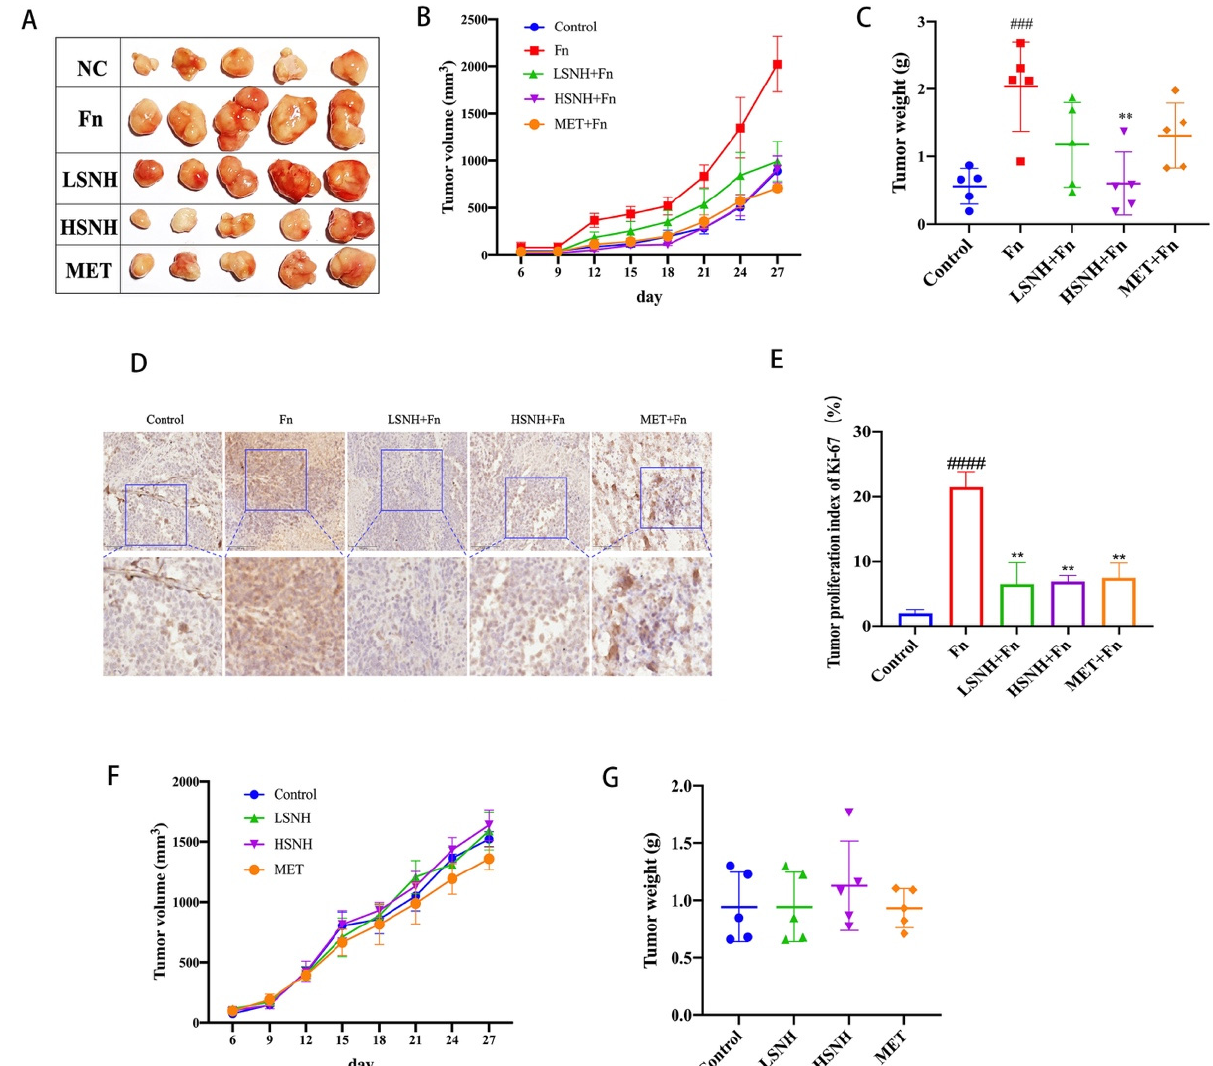
Figure 5. Effect of SNH on the growth of the CRC cells HCT116-xenograft tumors with intratumor colonization of Fn . ( A – C ), Gross image of tumors ( A ), tumor volume ( B ), and tumor weight ( C ) of tumors from the HCT116-engrafted mice inoculated with Fn in the presence of low-dose SNH (LSNH), high-dose SNH (HSNH), or the positive control drug MET. Time course effects of tumor volume were recorded in B. Endpoint of tumor appearance and tumor mass were shown in ( A , C ), respectively. ( D ) Immunohistochemistry of Ki-67 + cancer cells in the HCT116-tumor xenografts under different treatments as indicated. ( E ) Quantitation of Ki-67 + cancer cells in ( D ). ( F , G ) Tumor volume ( F ) and tumor weight ( G ) of HCT116 cells-xenografts in mice treated with LSNH and HSNH. All values were represented as mean ± SD, and p values < 0.05 were considered statistically significant. ** p < 0.01, vs. Fn group. ### p < 0.001, #### p < 0.0001, vs. Control.